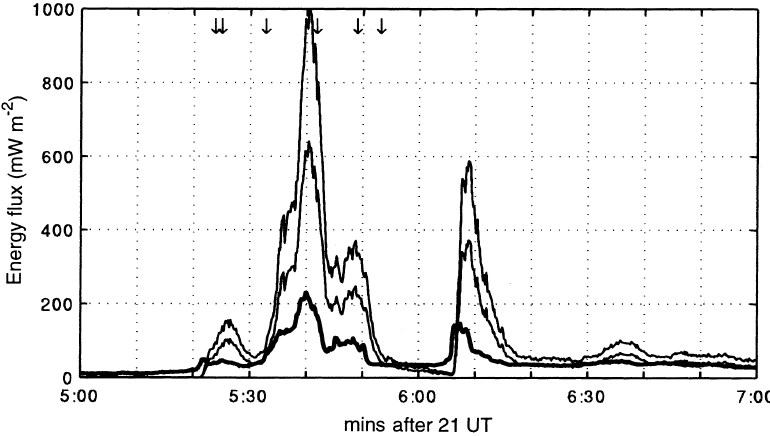
Fig. 4. a Measured 427.8-nm emission rate for 10 s during the second passage of the arc system. b Measured electron density at 0.2-s resolution during second passage of arc system. c Blue curve is the